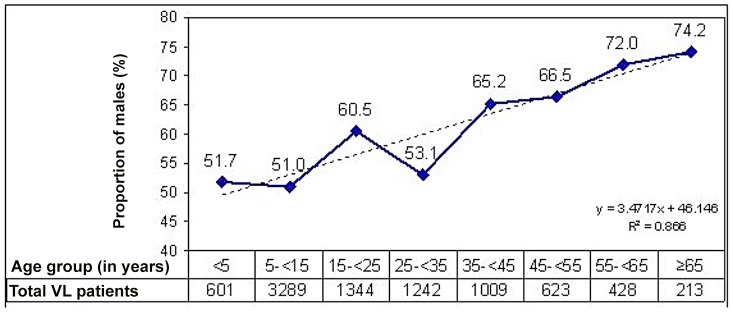
Age/sex ratio graph showing proportion of males admitted into programme by age.